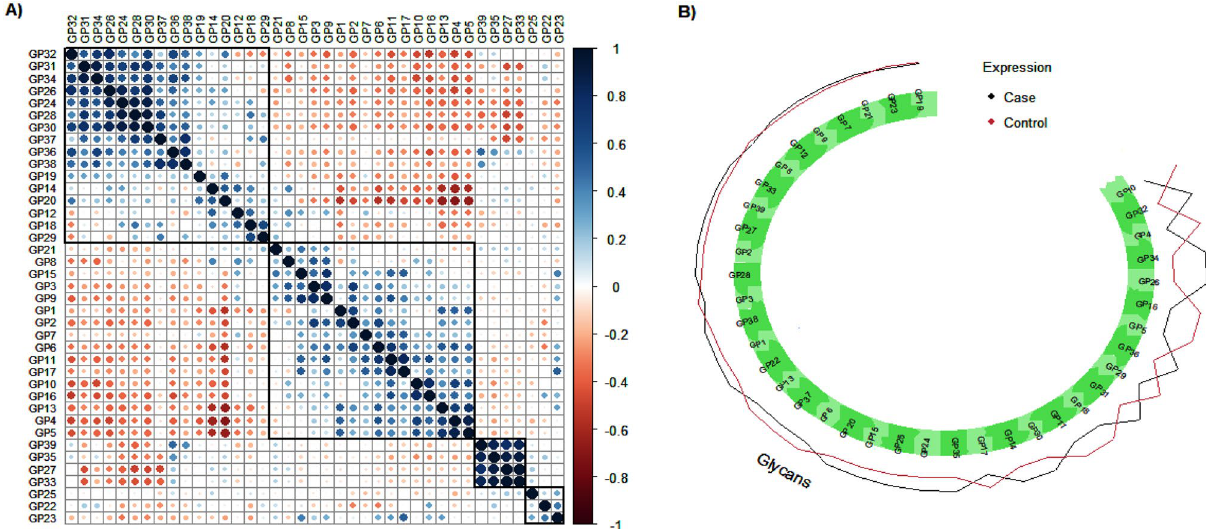
Figure 3. ( A ) Glycans correlation analysis for healthy controls and T2DM cases. The matrix presented are hierarchically clustered to highlight the signature of glycans expression in healthy controls and T2DM cases. ( B ) Expression of glycans in healthy controls and T2DM, ranked in terms of significant differing expression.